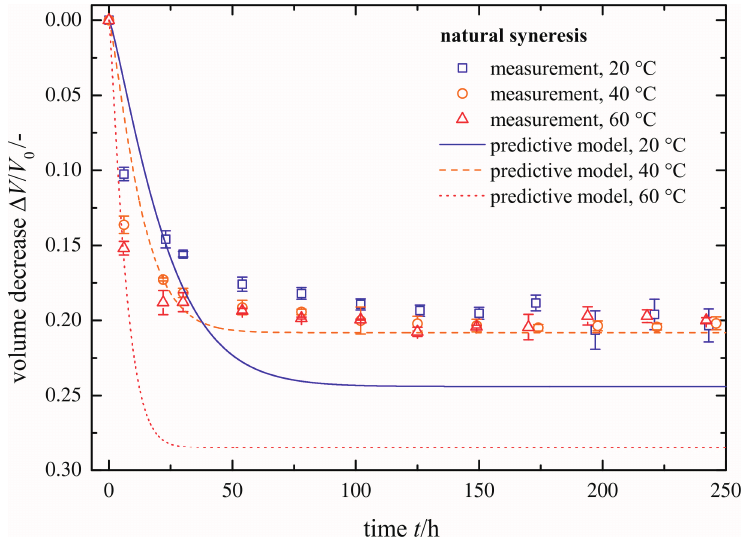
Figure 12. Comparison between measured and predicted progress of natural